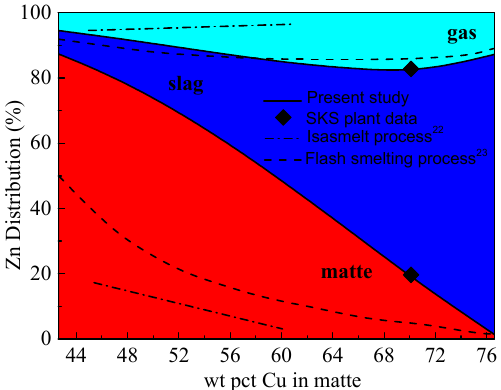
Figure 4. Zinc (Zn) distribution in the SKS smelting process.